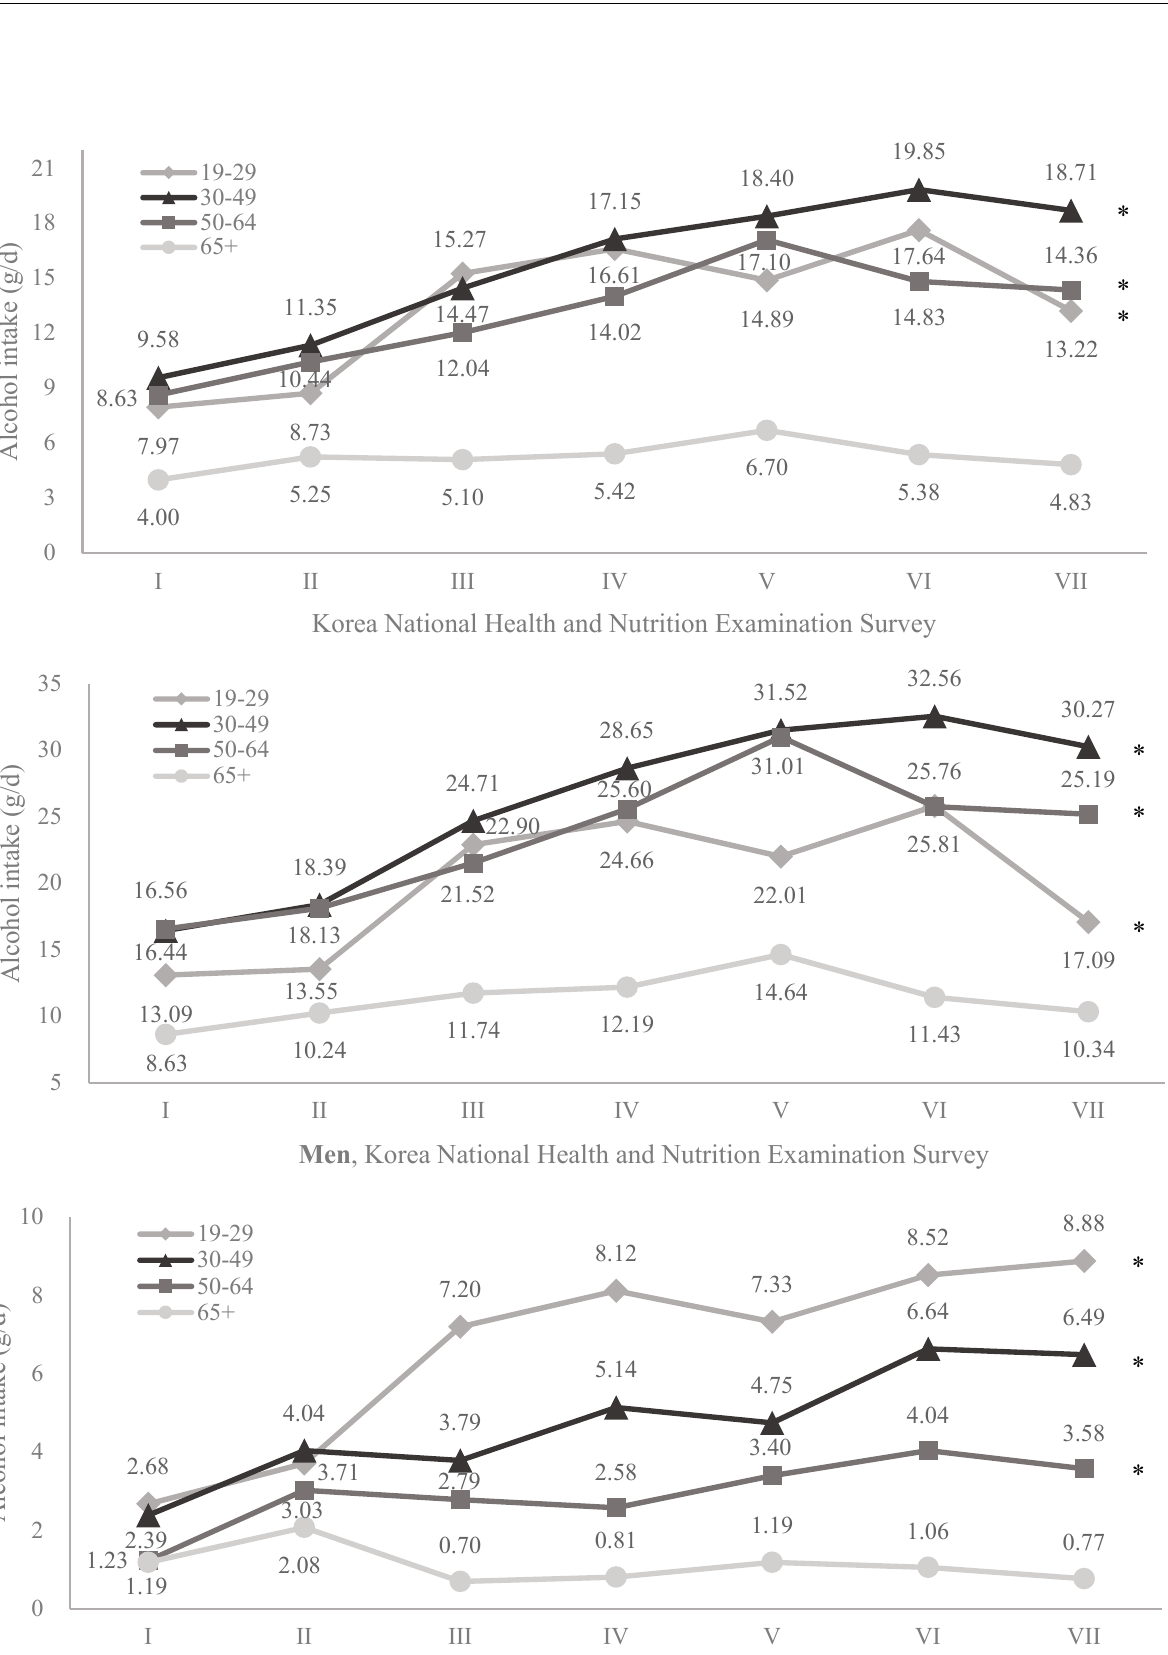
Figure 1. Changes in age-standardized pure alcohol intake by age group over time for Korean adults using the Korea National Health and Nutrition Examination Survey (KNHANES) (* p for trend < 0.05).